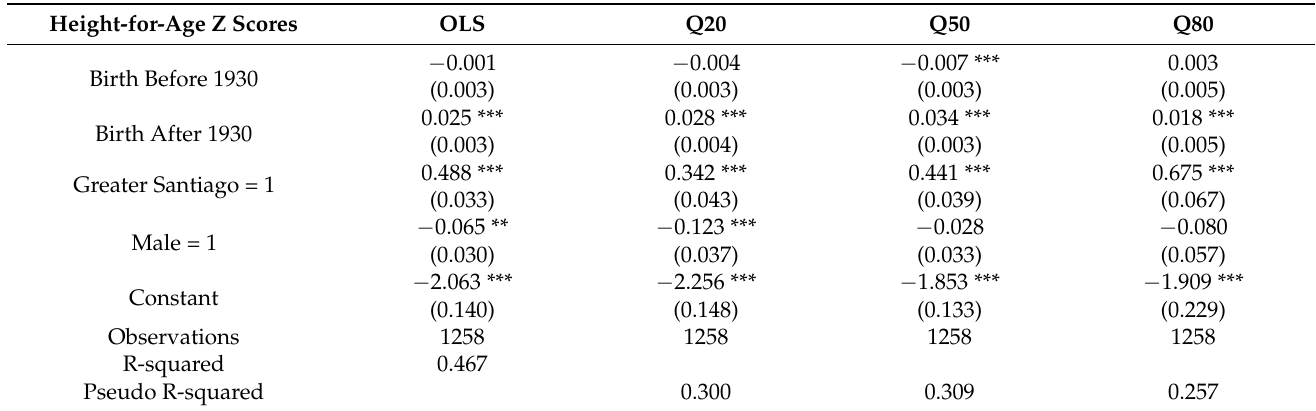
Table A2. OLS and quantiles regressions with breaks in 1930.